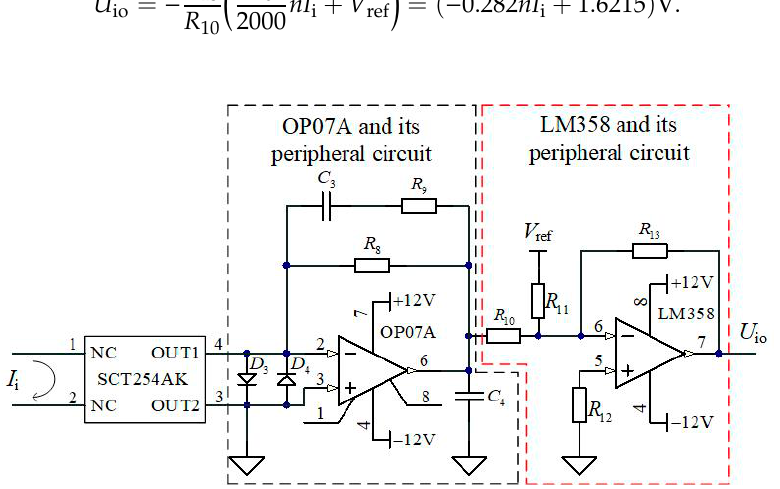
Figure 7. The schematic diagram of the signal conditioning circuit for a current transducer.